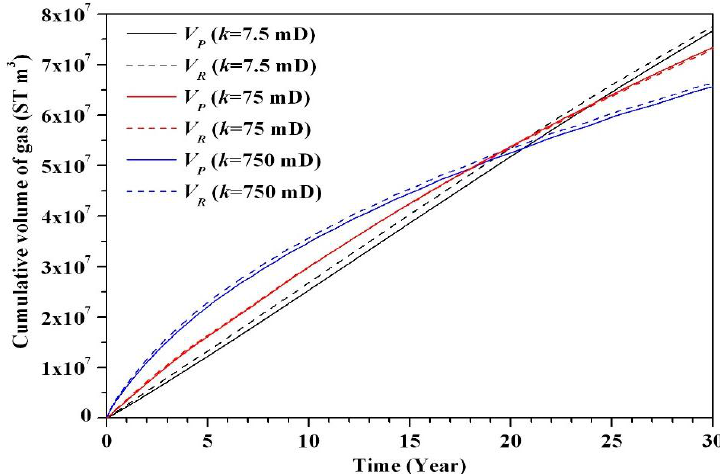
Figure 18. Sensitivity to the intrinsic permeability ( k ): evolution of V P and V R overtime.